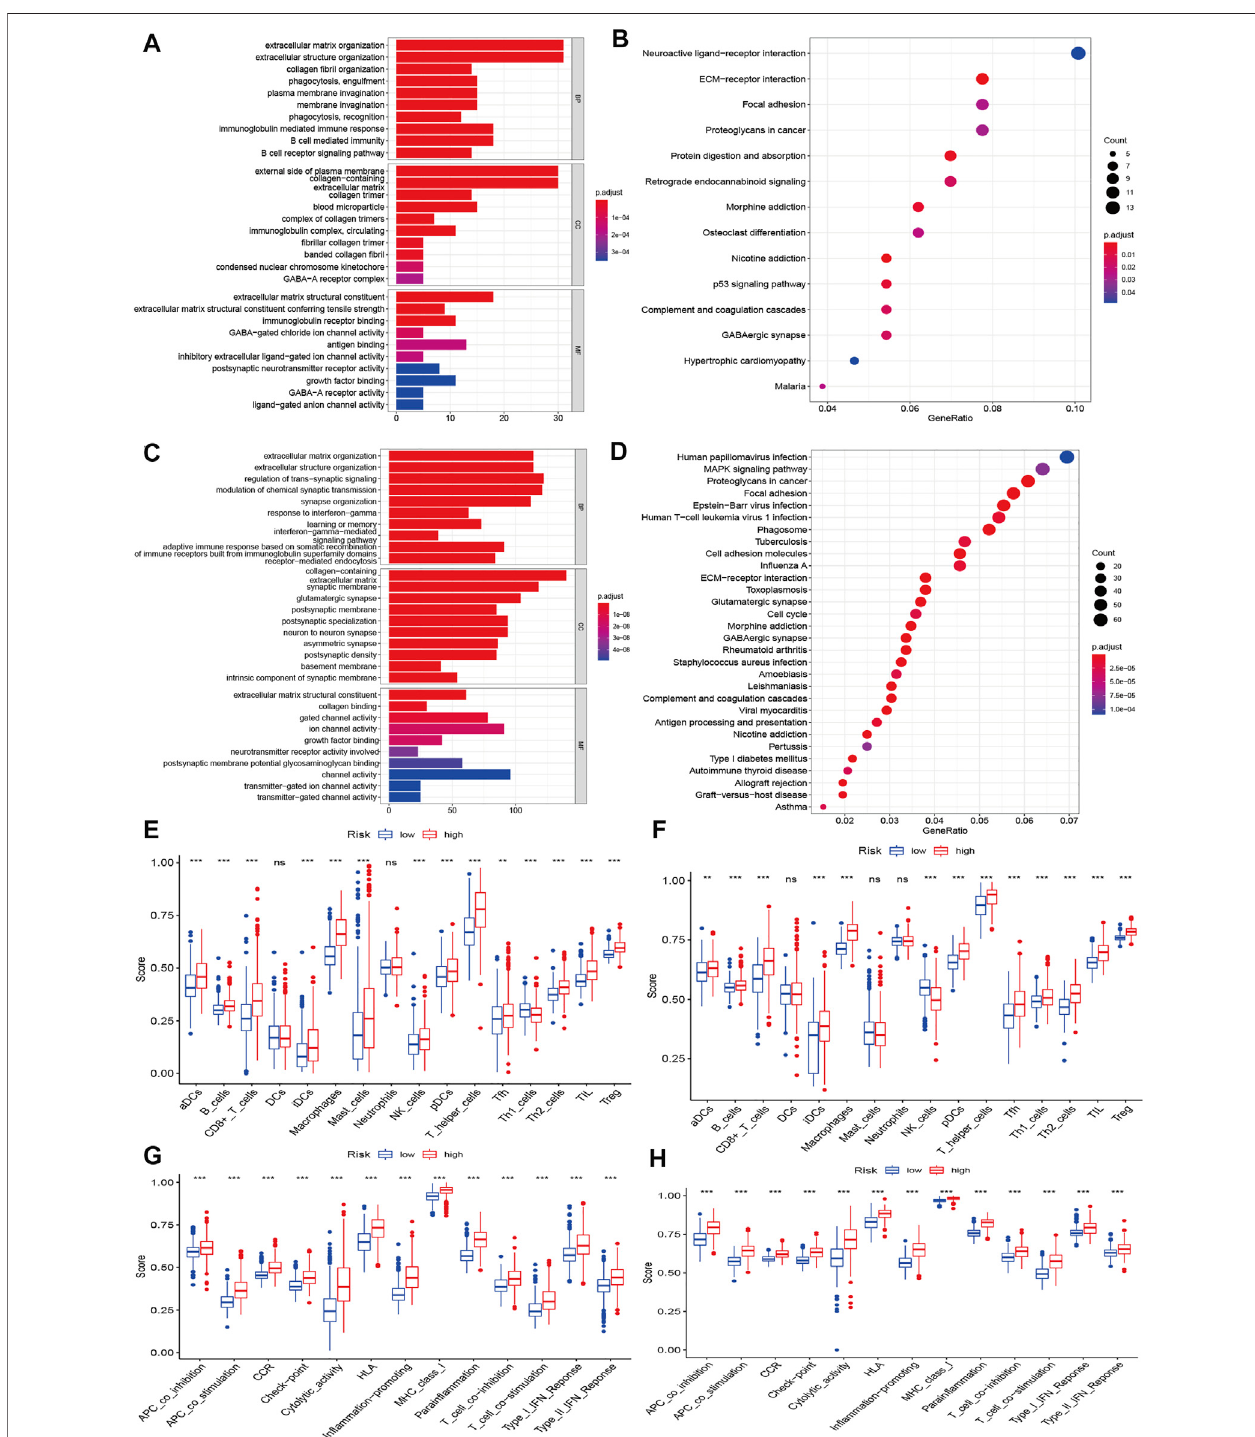
FIGURE 6 | Functional enrichment and immune status analysis. (A) Barplot of enrichment analysis based on prognostic-related signature genes in CGGA cohort. (B) Bubble plot of enrichment analysis based on prognostic-related signature genes in CGGA cohort. (C) Barplot of enrichment analysis based on prognostic-related signature genes inTCGAcohort. (D) Bubble plot ofenrichmentanalysisbased on prognostic-related signature genes in TCGA cohort. (E) Boxplot showed the ssGSEA scores for immune cells based on risk group in CGGA cohort. (F) Boxplot showed the ssGSEA scores for immune cells based on risk group in TCGA cohort. (G) Boxplot showed the ssGSEA scores for immune pathways based on risk group in CGGA cohort. (H) Boxplot showed the ssGSEA scores for immune pathways based on risk group in TCGA cohort.